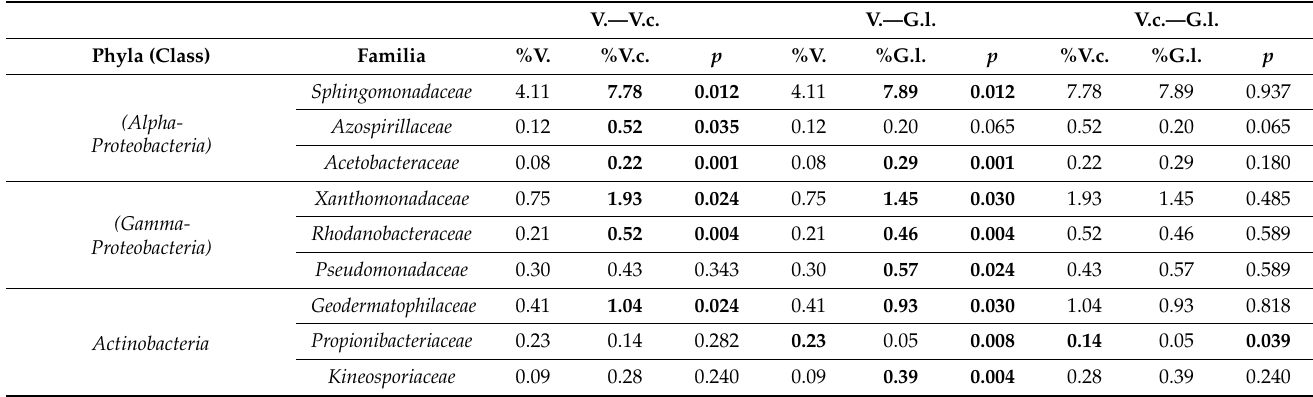
Table 5. Average percentage of families that differs in Voronic (V.) Vorony-Calcic (V.c.) and Grey-Luvic (G.l.) Chernozems. Bigger values and significance levels ( p ) for statistically significant differences given in